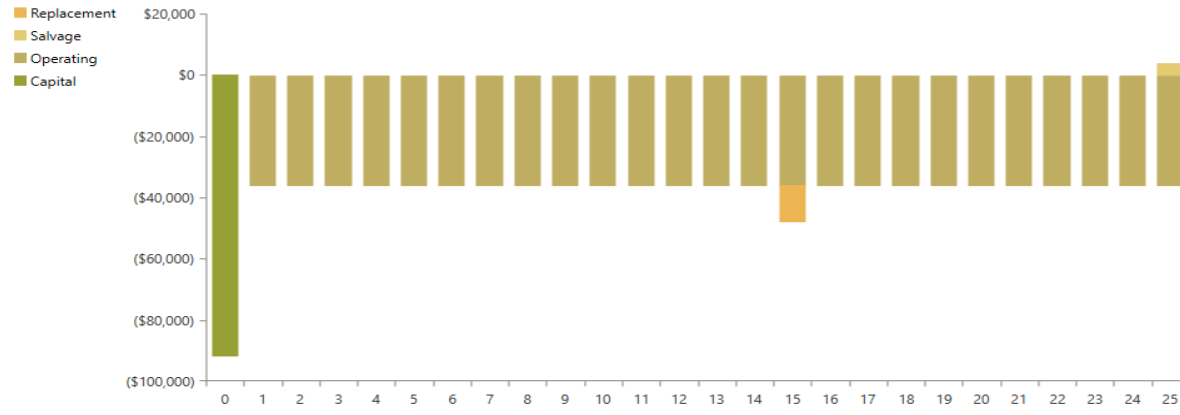
Figure 16. Summary of the system ’ s cash flow.